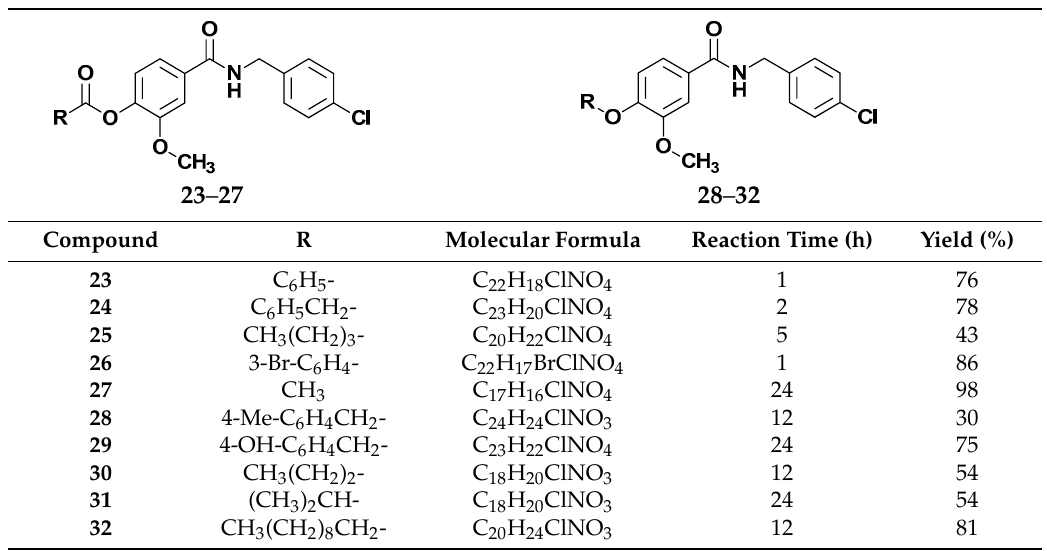
Table 2. Data from amide 15 derived ethers and esters.